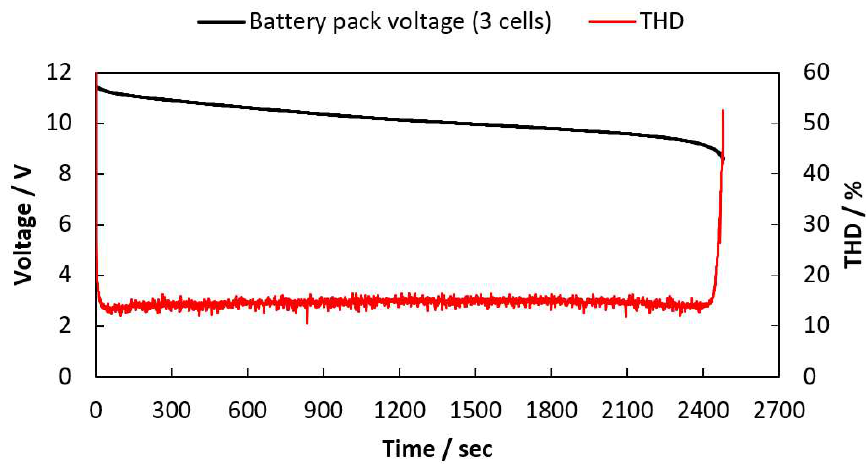
Figure 7. Battery pack voltage and THD measured during discharge.